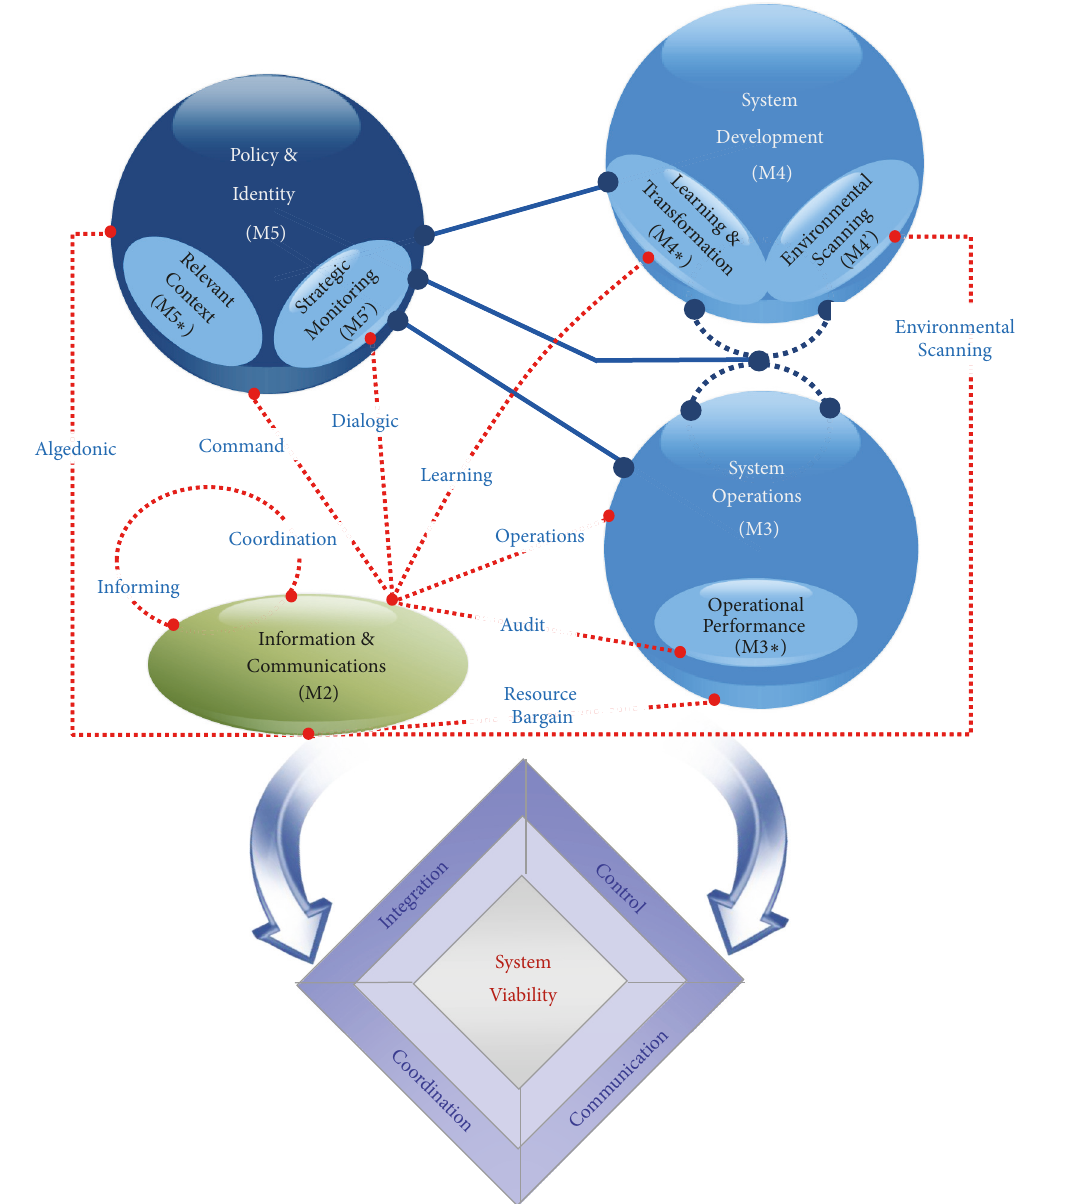
Figure 1: CSG metasystem functions (modified from